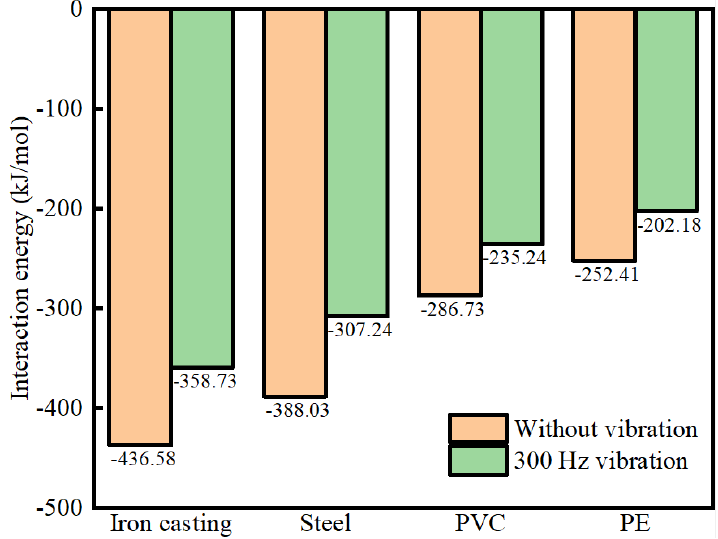
Figure 12. The interaction energy (kJ/mol) between water drops and the different pipelines.